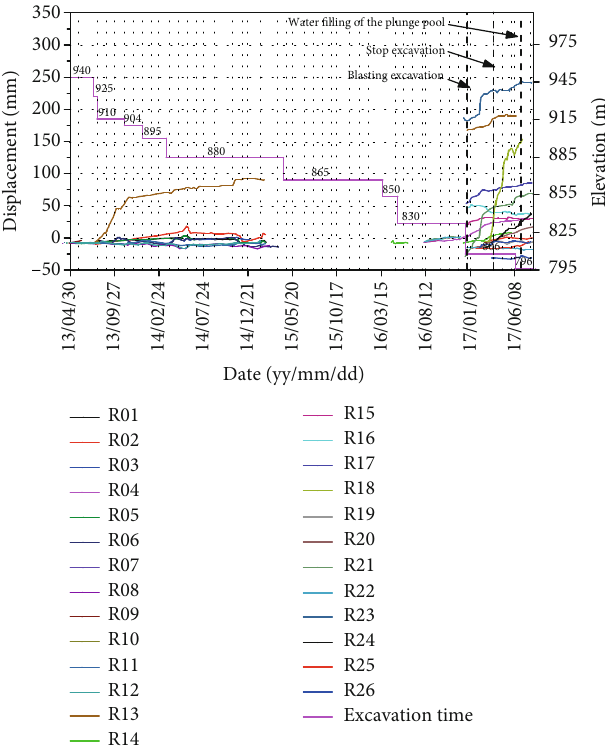
Figure 8: Comparison curve between the stress change of anchor stress meter and the excavation